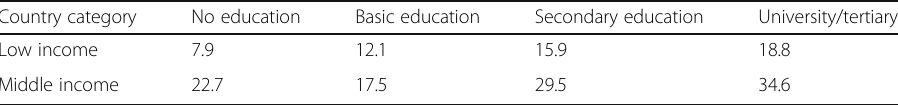
Source: African Development Bank (AfDB) et al.